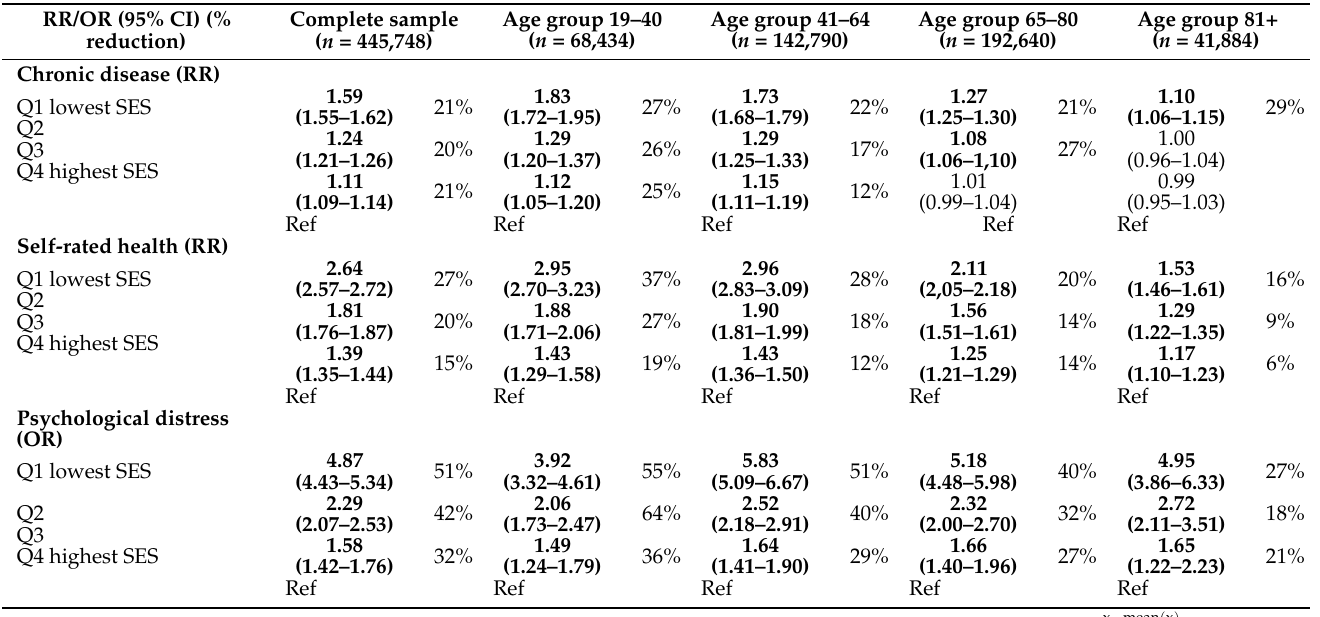
Table 3. Associations for the complete sample and four age groups with the three health outcomes, adjusted for demographic factors, SES, and loneliness (model 3). RR/OR (95% CI) (%